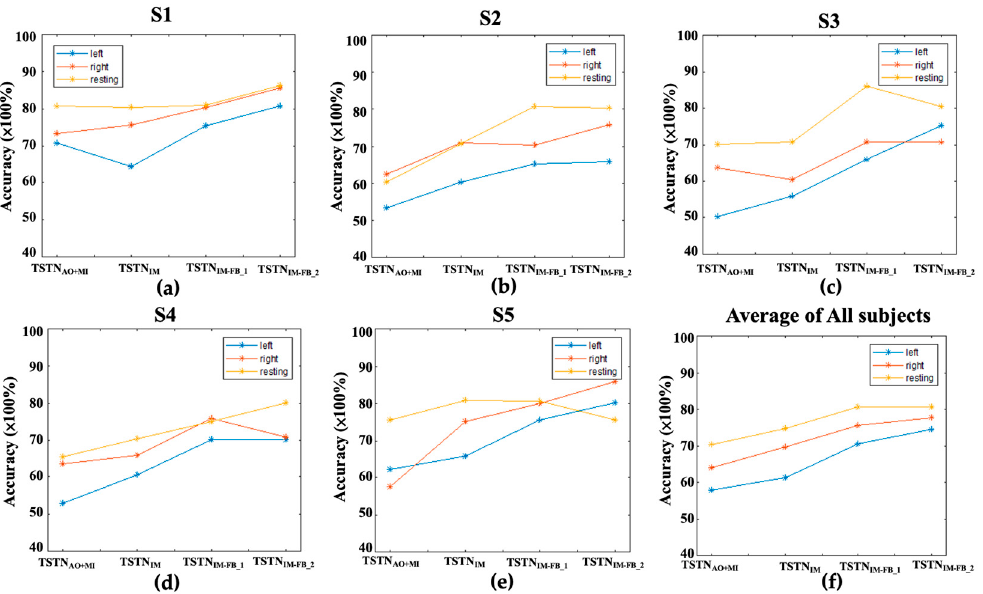
Figure 5. The detected accuracies by applying the TSTN AO , TSTN MI , TSTN MI-FB_1 , and TSTN MI-FB_2 to